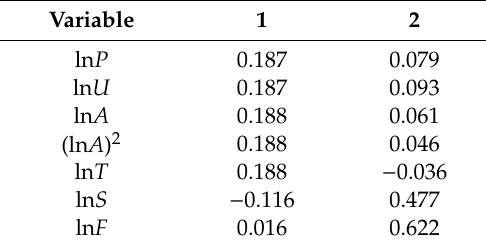
Table 8. Principal component coe ffi cient.